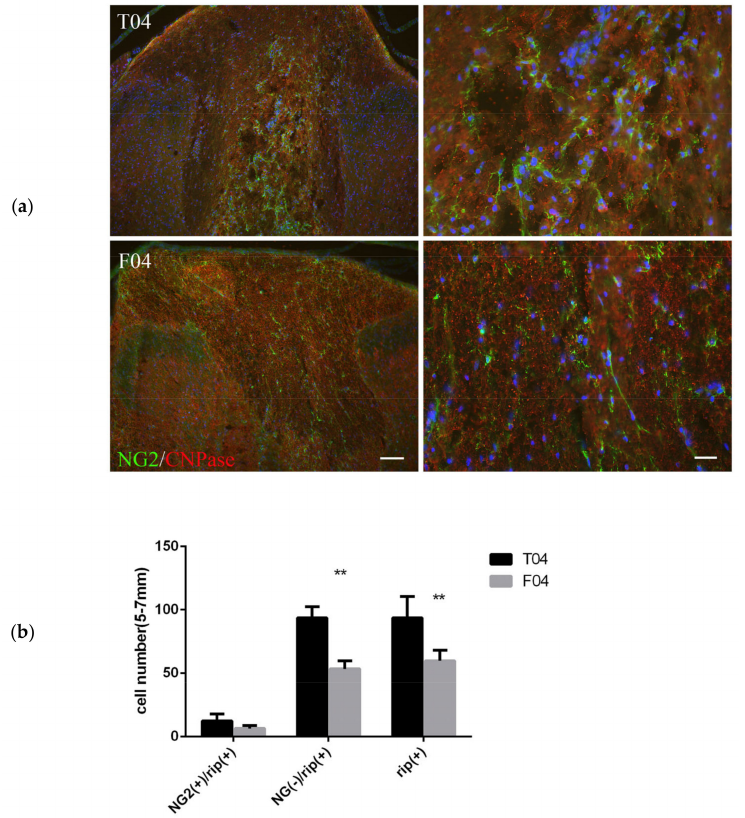
Figure 6. CNPase and NG2 double staining was used to study the maturation of the OPC cell popula- tions. ( a ) Left panel is the overview of the dorsal funiculus. Right panel is the higher